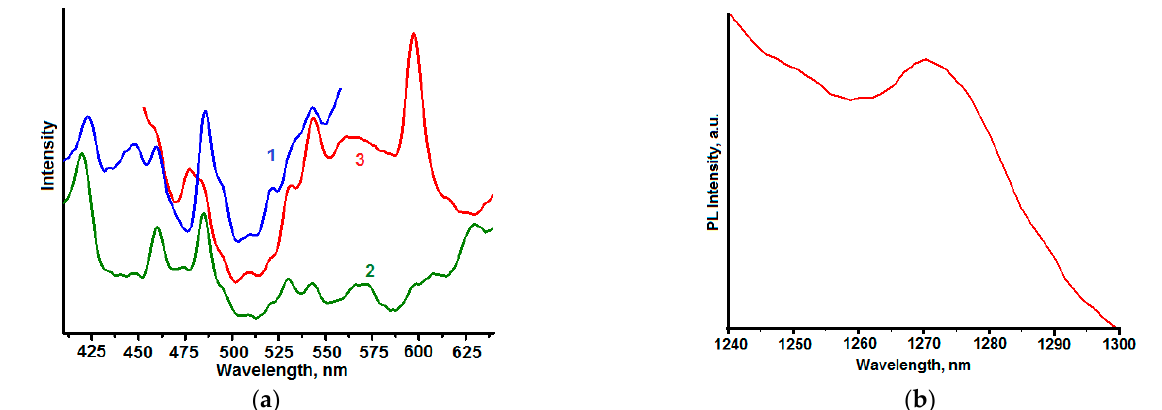
Figure 4. ( a ) Photoluminescence spectra of powder sample 3 in the visible diapason. Excitation wavelengths, nm: 300 (curve 1); 350 (curve 2); 400 (curve 3). ( b ) Photoluminescence spectra of powder sample 3 in NIR spectral range. Excitation wavelength 405 nm.